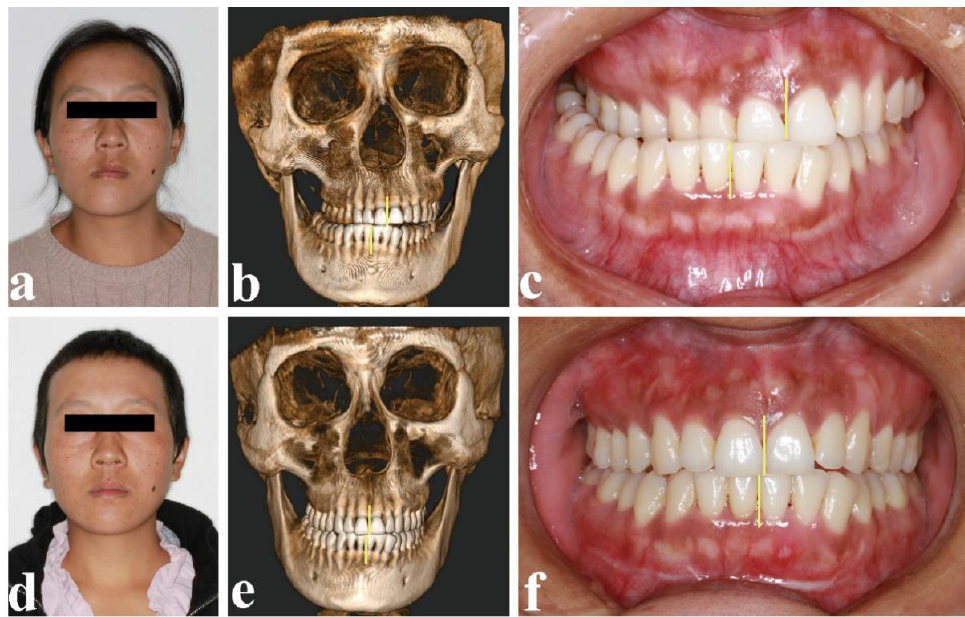
Figure 6. The change of facial profile, 3D CT image, and occlusion preoperatively and 1 year after surgery: ( a , d ) frontal profile, preoperatively and postoperatively; ( b , e ) frontal 3D CT image, preoperatively and postoperatively; ( c , f ) intraoral view, preoperatively and postoperatively (yellow line—middle line of upper and lower jaw).